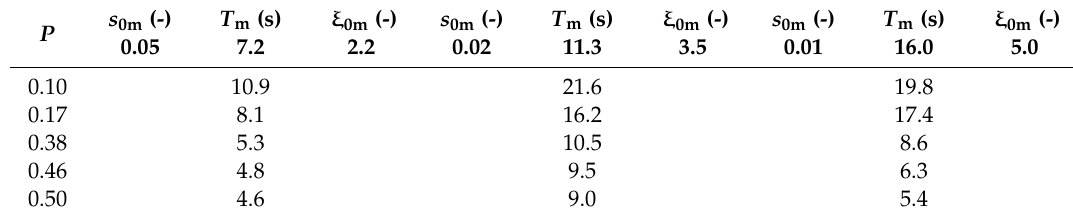
Table 1. Estimated rock armor weight in tonnes with the use of the Van der Meer [1]